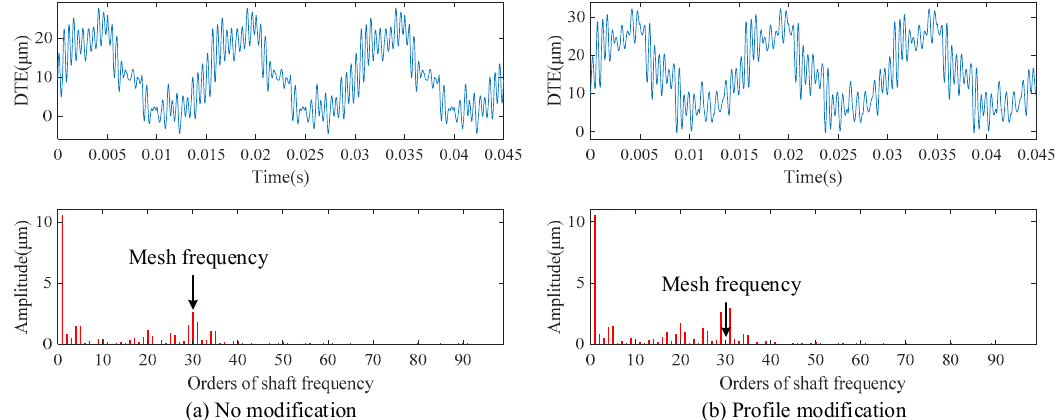
Figure 15. DTEs of modified and unmodified helical gear pair considering random cumulative pitch deviations.